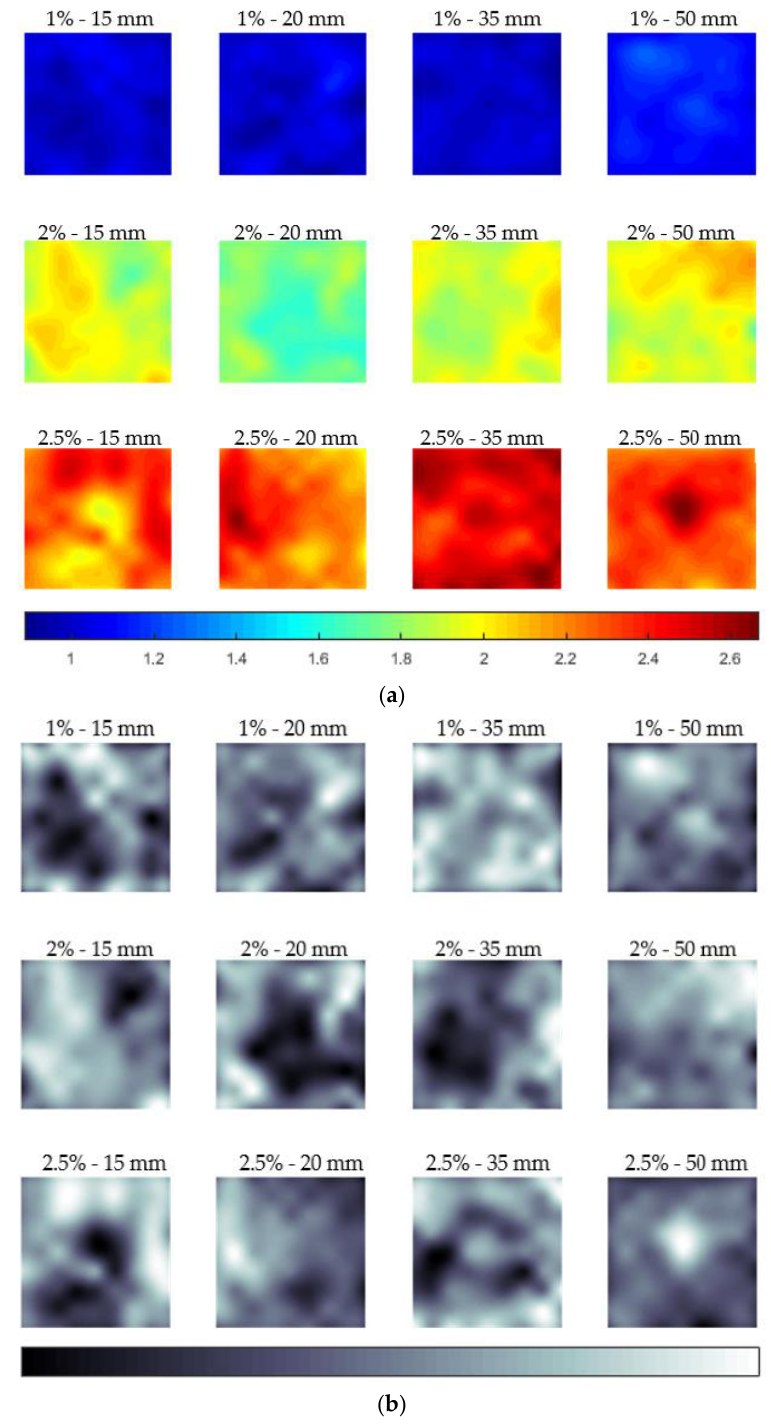
Figure 9. Fibre volume content distribution of all plates. ( a ) With a scale as the fibre volume content in percentage and ( b ) with a general non-unified scale.